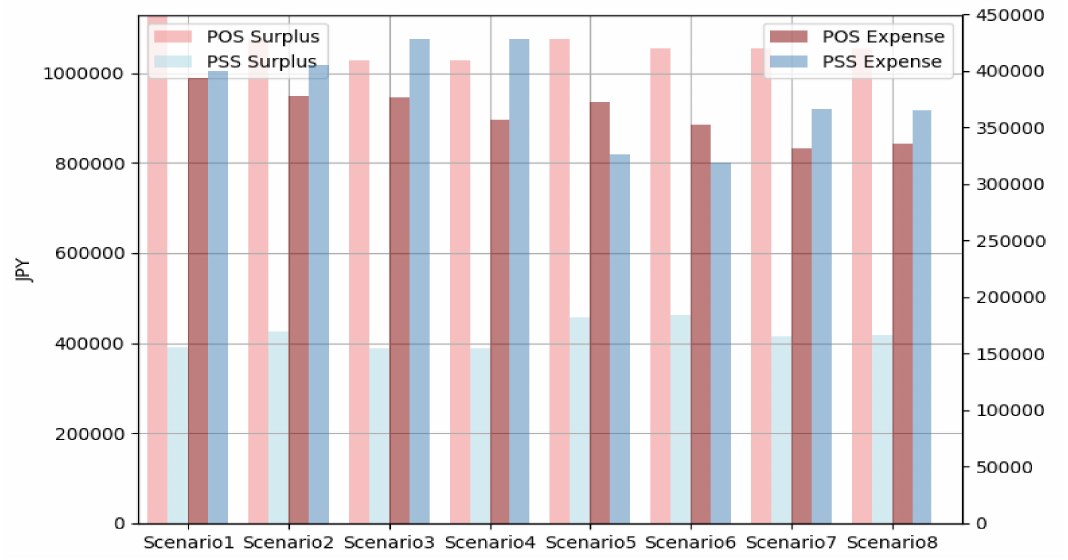
Figure 11. POS & EPSS Economic Benefit